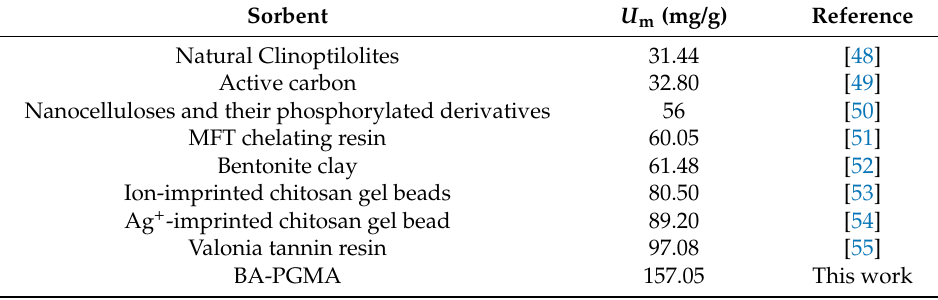
Table 5. Comparison of the adsorption amount of Ag(I) and adsorbent reported in the literature.